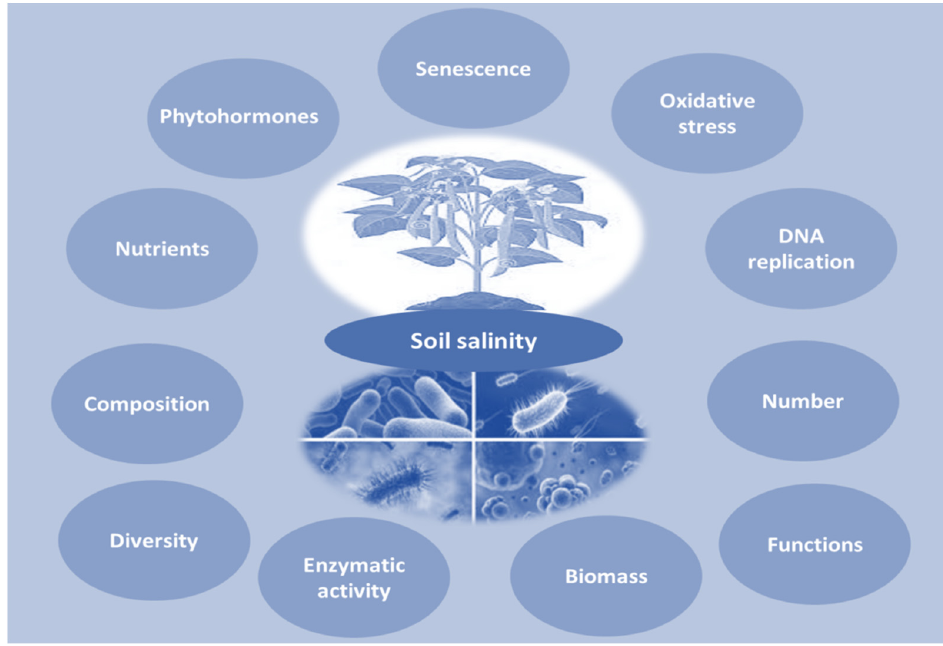
Figure 2. Adverse impacts of soil salinity on plants and microorganisms.